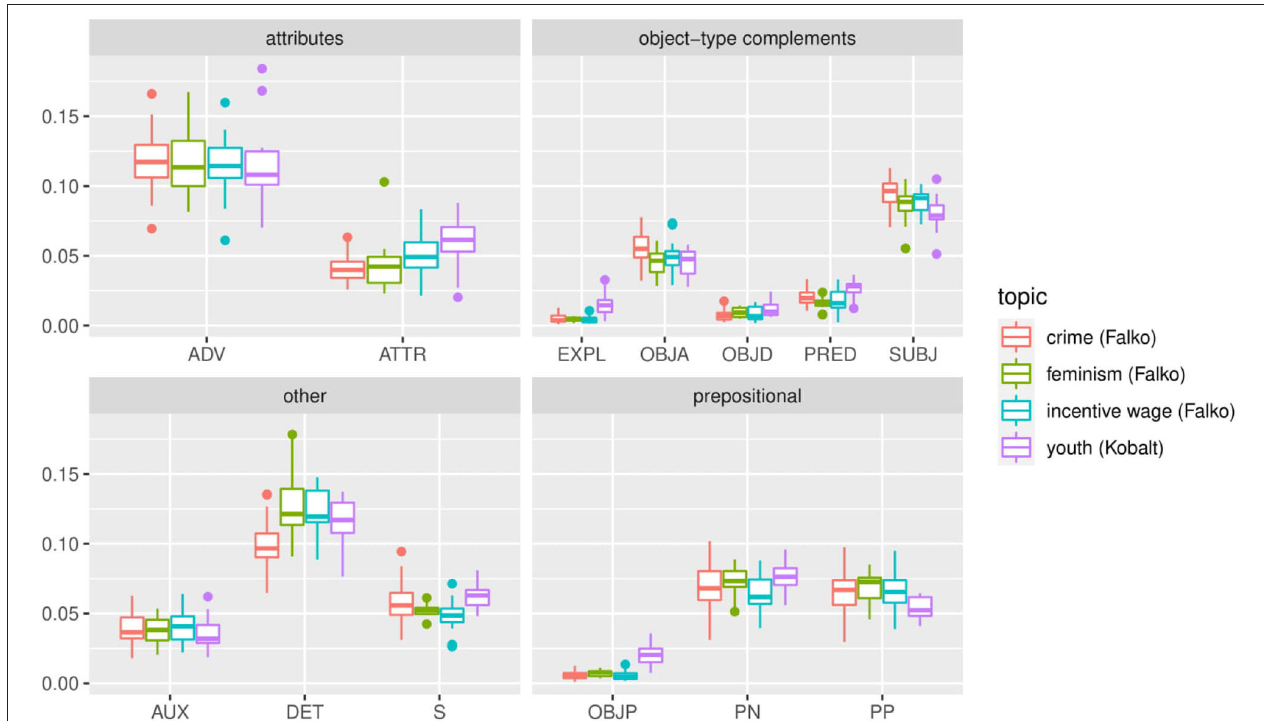
FIGURE 8 | Distribution of frequent dependency types in Falko and Kobalt relative to text length. Dependencies included: adverb and attribute (attributes), prepositions in free PPs and prepositional objects, nominal compliments to PPs (prepositional), subjects, predicates, accusative and dative objects (object-type complements), determiners, lexical, and auxiliary verbs (other). Although frequencies are overall more stable compared to morphological subclasses of verbs and nouns, there still are noticeable differences by topic/corpus (more attributes, prepositional objects, lexical verbs (S) in Kobalt; fewer determiners, more subjects in the crime topic in Falko. This might be due to differences in lexical choice or in register